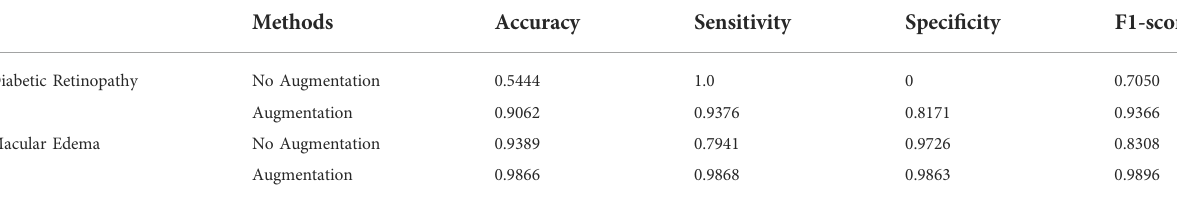
TABLE 5 Performance of binary classi fi cation before and after data augmentation.